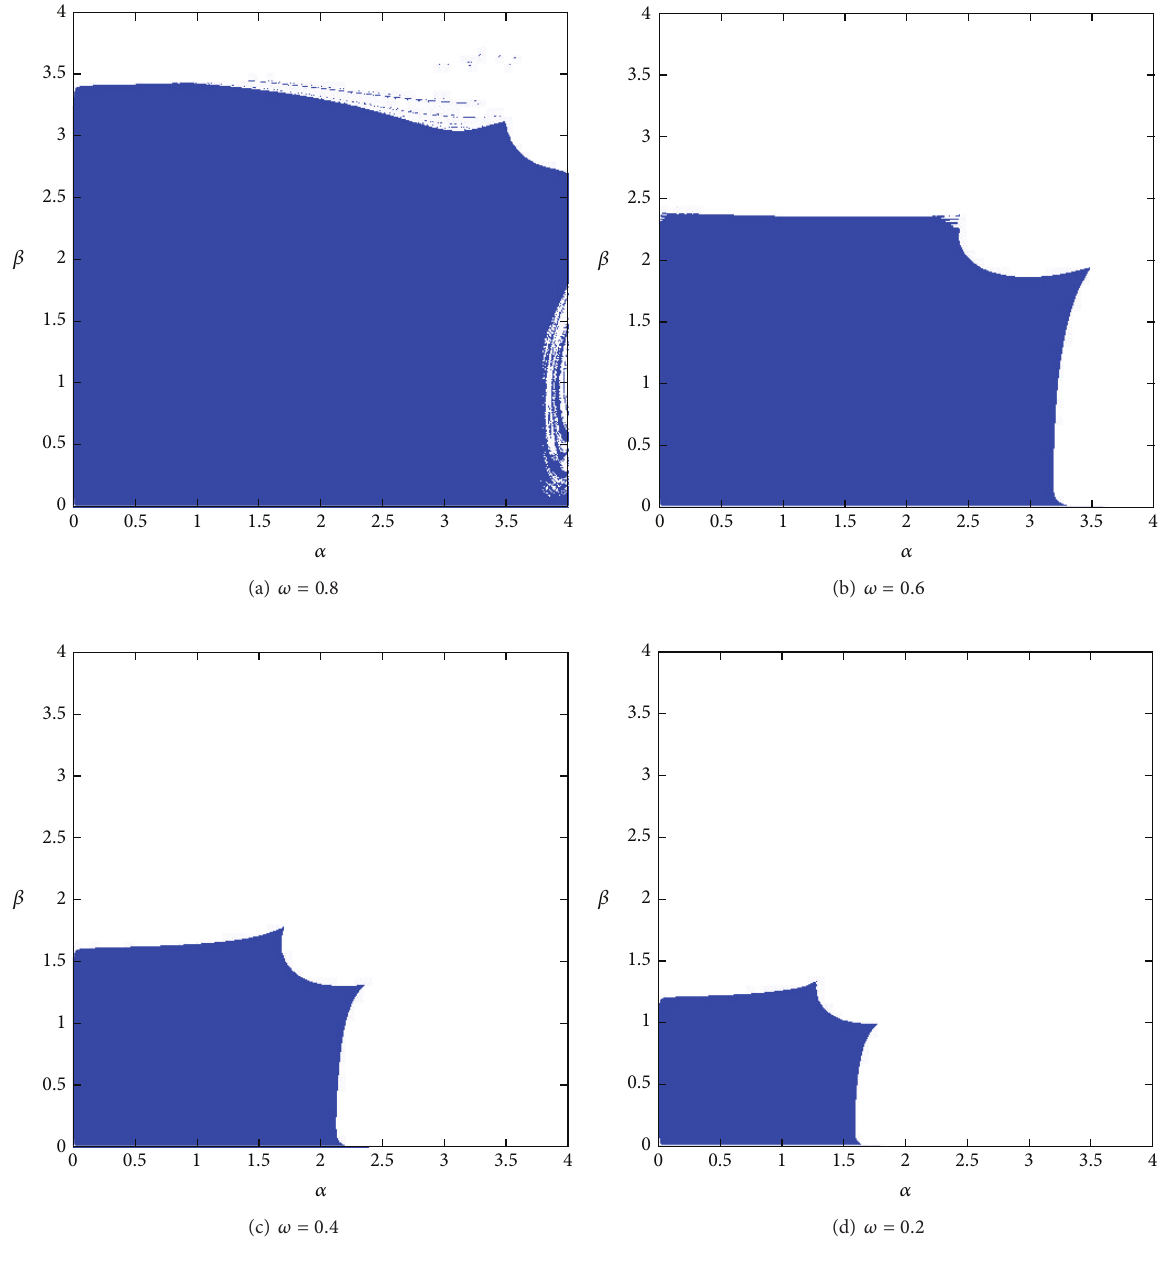
Figure 10: The stability region (dark blue) of the Nash equilibrium point 𝐸 ∗ of system (11) with 𝜔 1 = 𝜔 2 = 𝜔 varying.